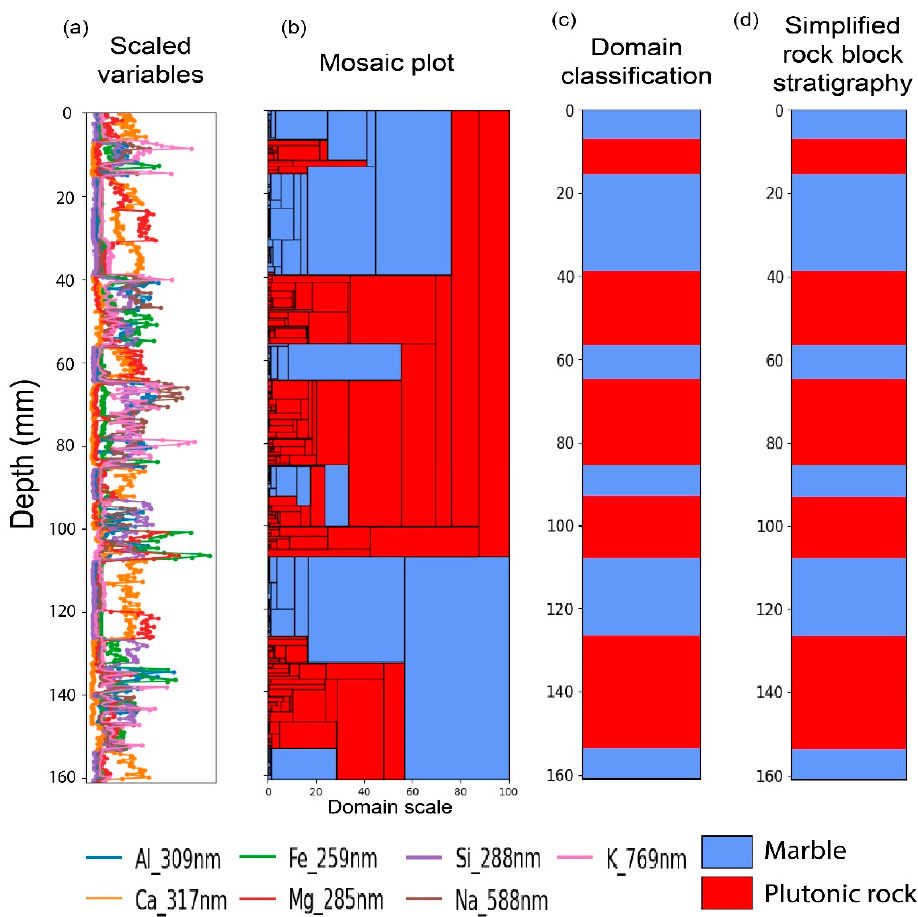
Figure 6. Results for k = 2 cluster analysis of raw laser-induced breakdown spectroscopy (LIBS) data based on classification by k -means clustering. ( a ) Scaled variables; ( b ) multiscale mosaic plot showing the boundaries detected by wavelet tessellation from raw LIBS data with the k = 2 cluster classification applied; ( c ) simplified marble vs. plutonic rocks block stratigraphy based on laboratory whole-rock geochemistry; ( d ) pseudolog of the domain classification at domain scale = 0.